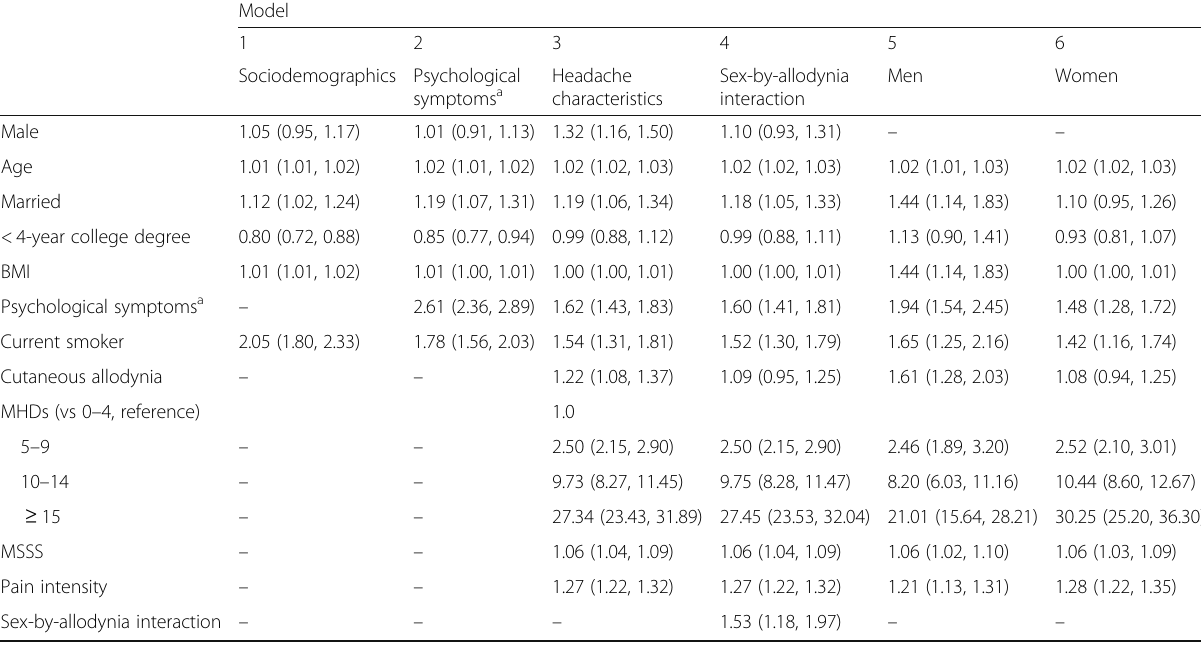
Table 3 Risk (odds ratios [95% CI]) of Medication Overuse Among Respondents with Migraine Currently Using Acute Medication for Headache (N =